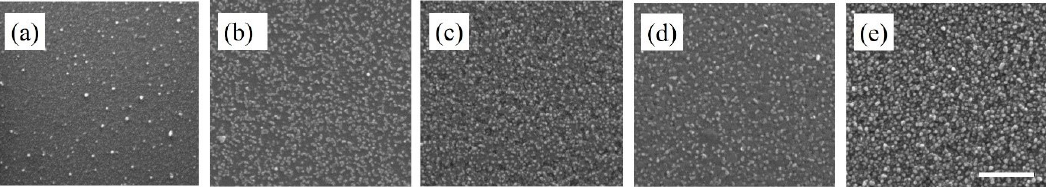
Figure 7. SEM images of Cu-based nanostructures deposited on Si substrate after ( a ) first, ( b ) second, ( c ) third, ( d ) fourth, ( e ) fifth deposition cycle with CTAB added as surfactant. The scale bar is 500 nm.